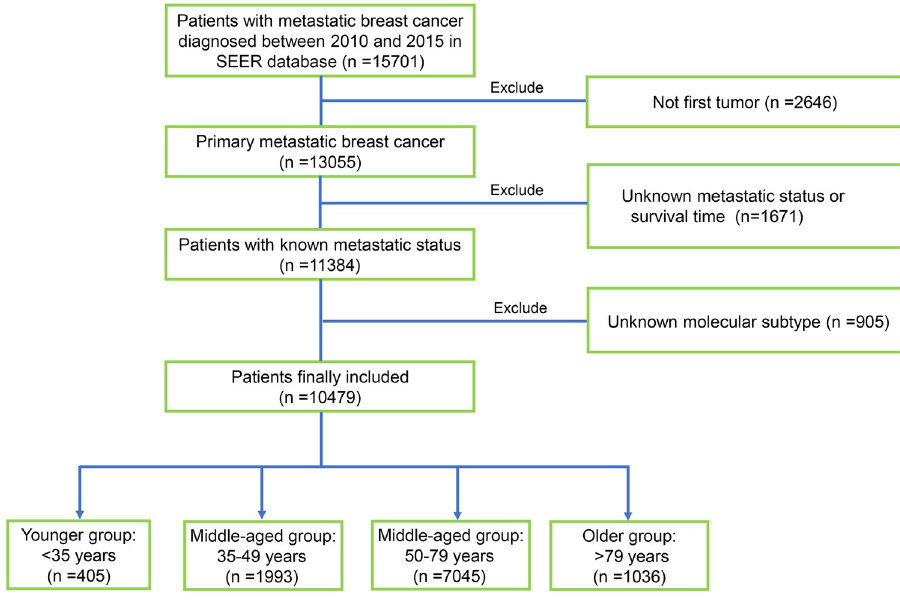
Fig 1. The flowchart of patients’